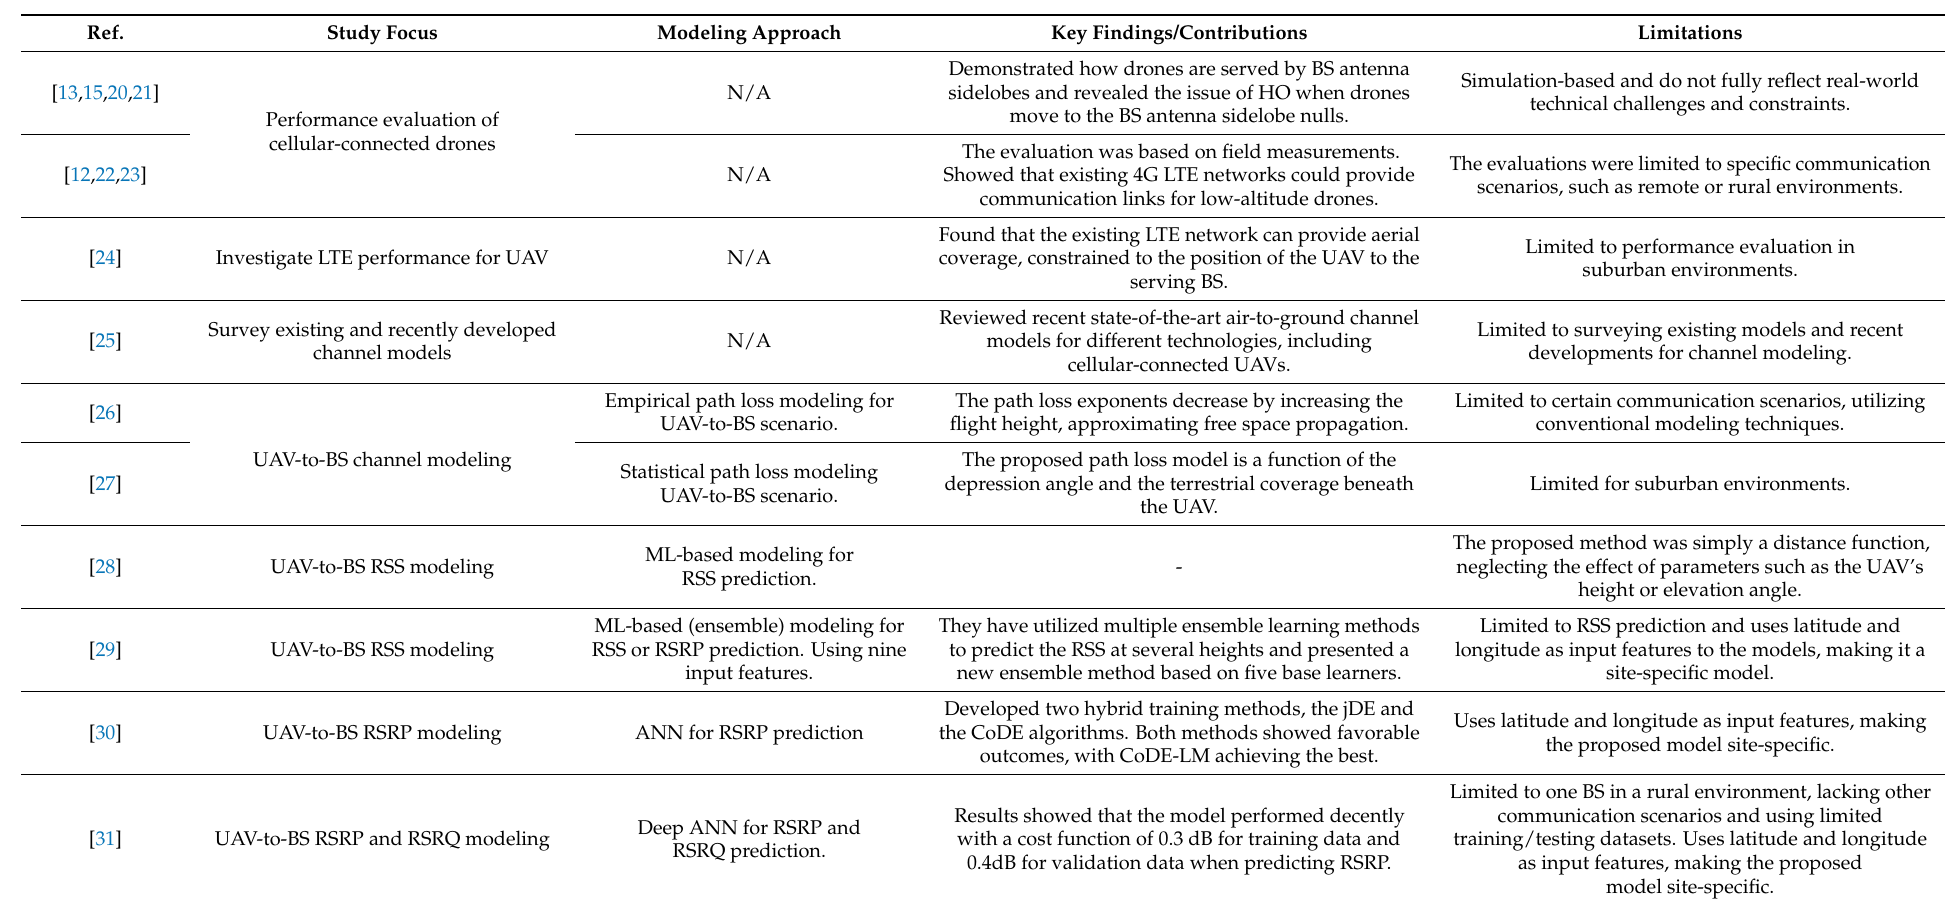
Table 1. A summary of the reviewed UAV-to-BS channel modeling and characterization